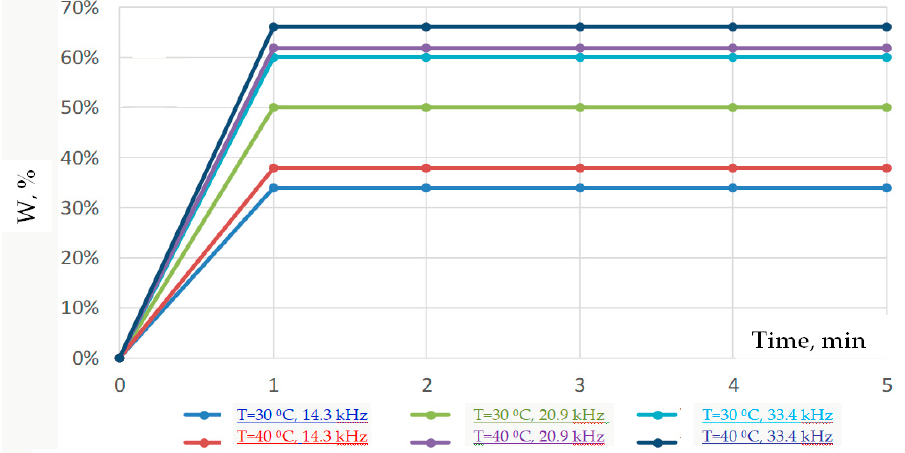
Figure 7. Kinetics of water precipitation of the W/OE sample of the studied deposit under various spectral ultrasonic effects (14.3 kHz, 20.9 kHz, 33.4 kHz) at temperatures of 30 °C and 40 °C without the introduction of a demulsifier (ultrasonic sounding time 60 s).